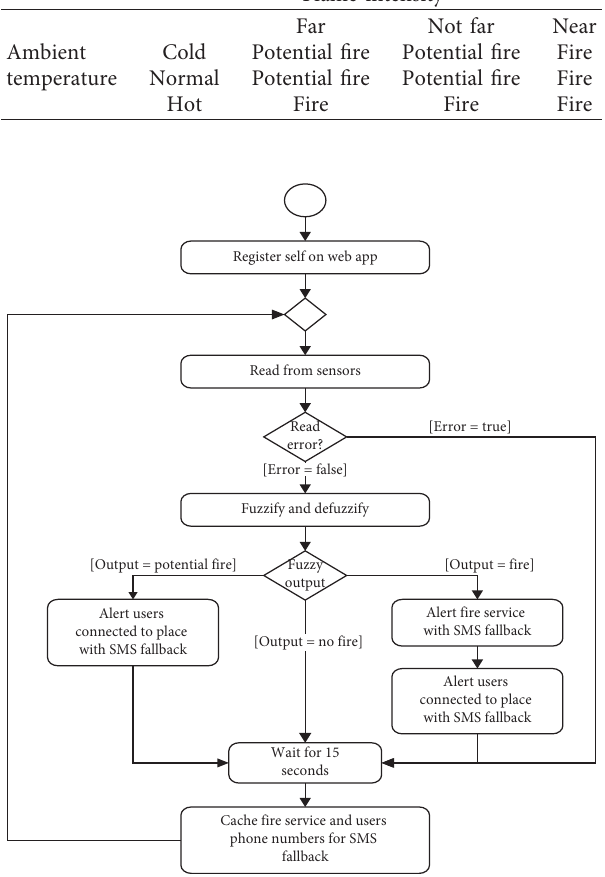
Figure 5: Flow diagram for fire detection